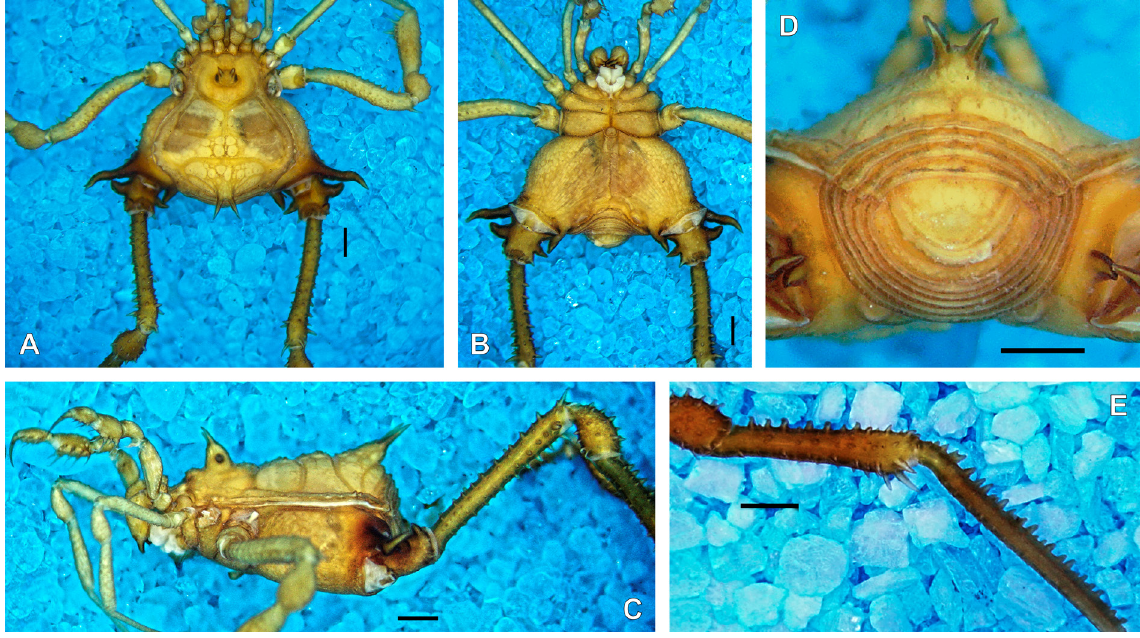
Fig. 6. Lacronia boraceae (B. Soares, 1942) comb. nov., ♂ (MNRJ-HS 122 ꜝ ), specimen in alcohol. A . Habitus, dorsal view. B . Same, ventral view. C . Same, lateral view. D . Armature of mesotergum area III, free tergites I–III and anal operculum, posterior view. E . Right Pa–Ti IV, retro-lateral view. Scale bars = 1